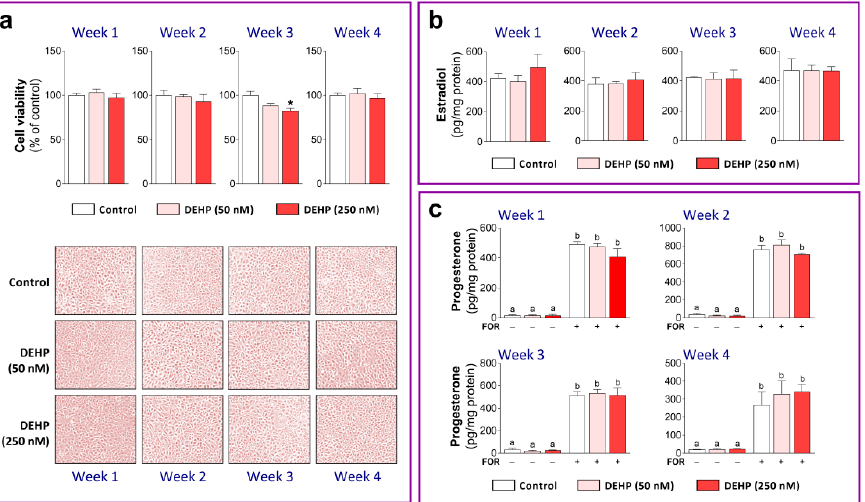
Figure 2. Viability and steroidogenesis in DEHP-exposed HGrC1 cells. ( a ) Cell viability was assessed using the Alamar Blue assay. Results are expressed relative to the vehicle-treated control, which was set as 100% in each week. Representative images of the control and DEHP-exposed HGrC1 cells after 1, 2, 3, and 4 weeks are shown. ( b ) Estradiol and ( c ) progesterone production in the culture medium were measured using ELISA. Each data point represents the mean ± SEM of three independent experiments. * p < 0.05 vs. control. Different superscript letters indicate statistically significant differences among treatment groups ( p < 0.05).